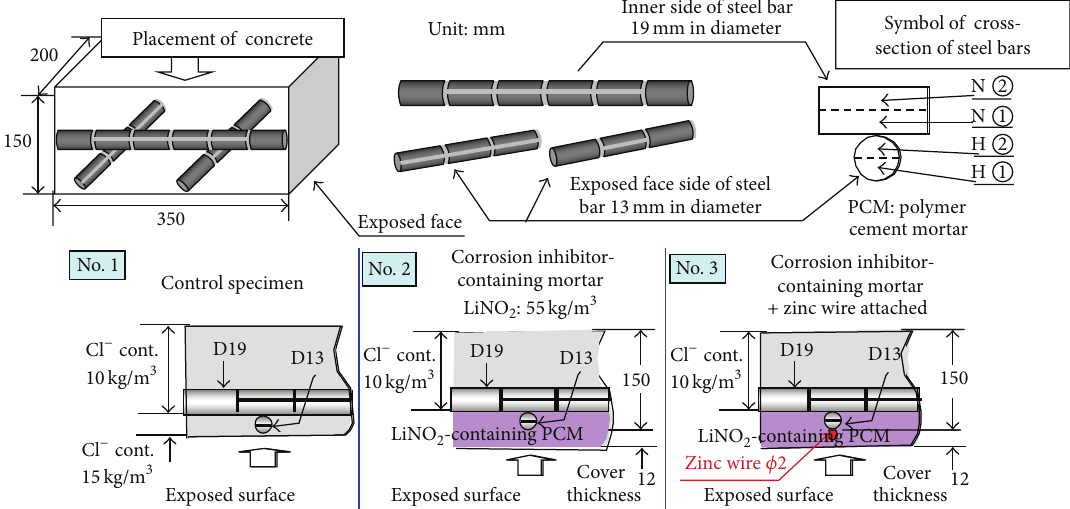
Figure 10: Specimens of exposure tests for confirming the effectiveness of zinc wire as a galvanic anode.